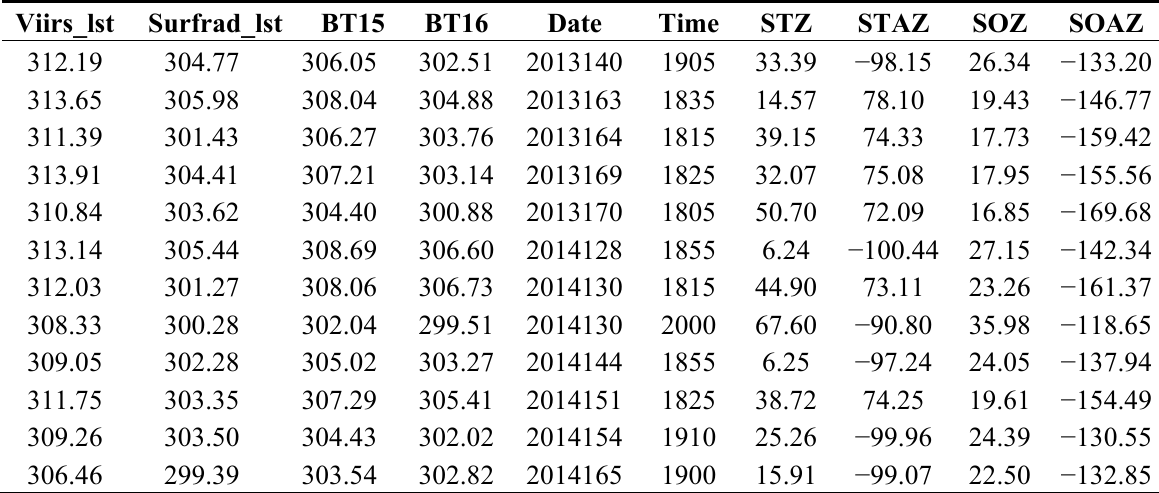
Table 4. Details about the match ups over Bondville site with higher satellite LST retrievals than ground measurements.